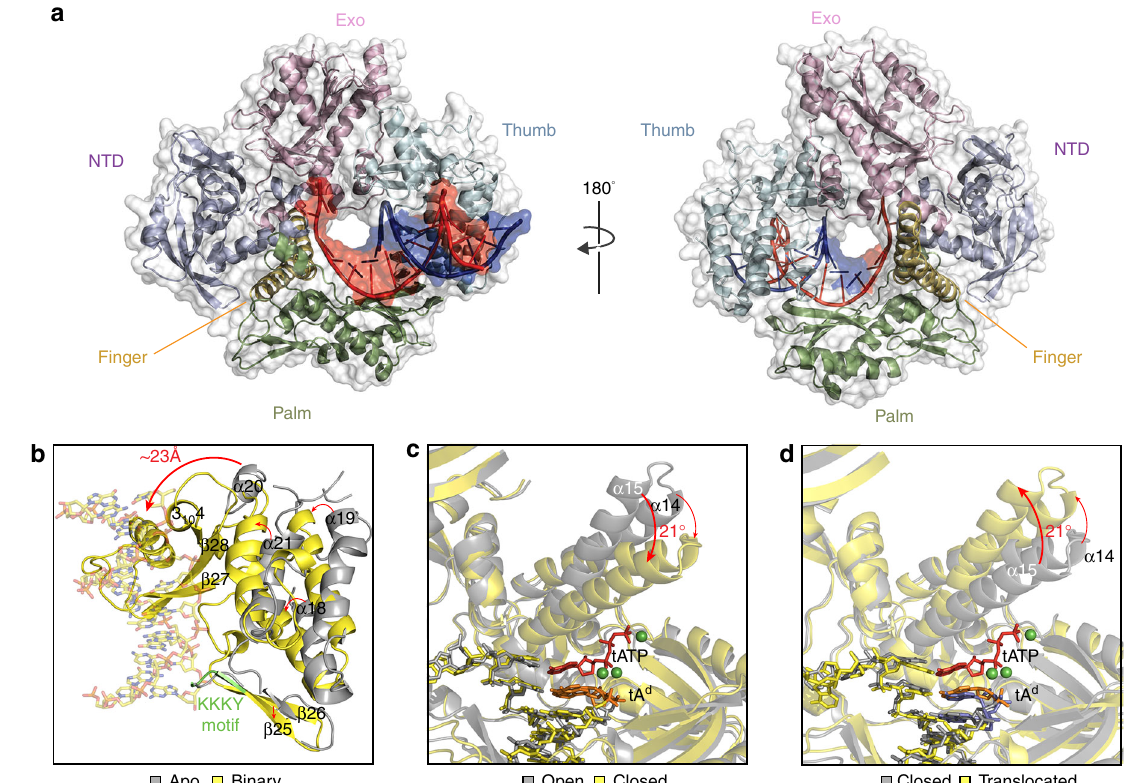
Fig. 3 Structure and conformational changes. a Global architecture of Kod-RI bound to a P/T duplex. Front (left) and back (right) views of Kod-RI colored by domain with the template and primer strands shown in red and blue, respectively. Structural changes observed during primer – template binding b , nucleoside triphosphate binding c , and translocation d . The 2 ′ -deoxy threose adenosine (tA d ) residue at the 3 ′ -terminus of the DNA primer is colored in orange to distinguish it from the DNA portion of the P/T duplex (yellow sticks). Magnesium ions appear as green spheres. In the translocated structure d , the TNA residues are colored